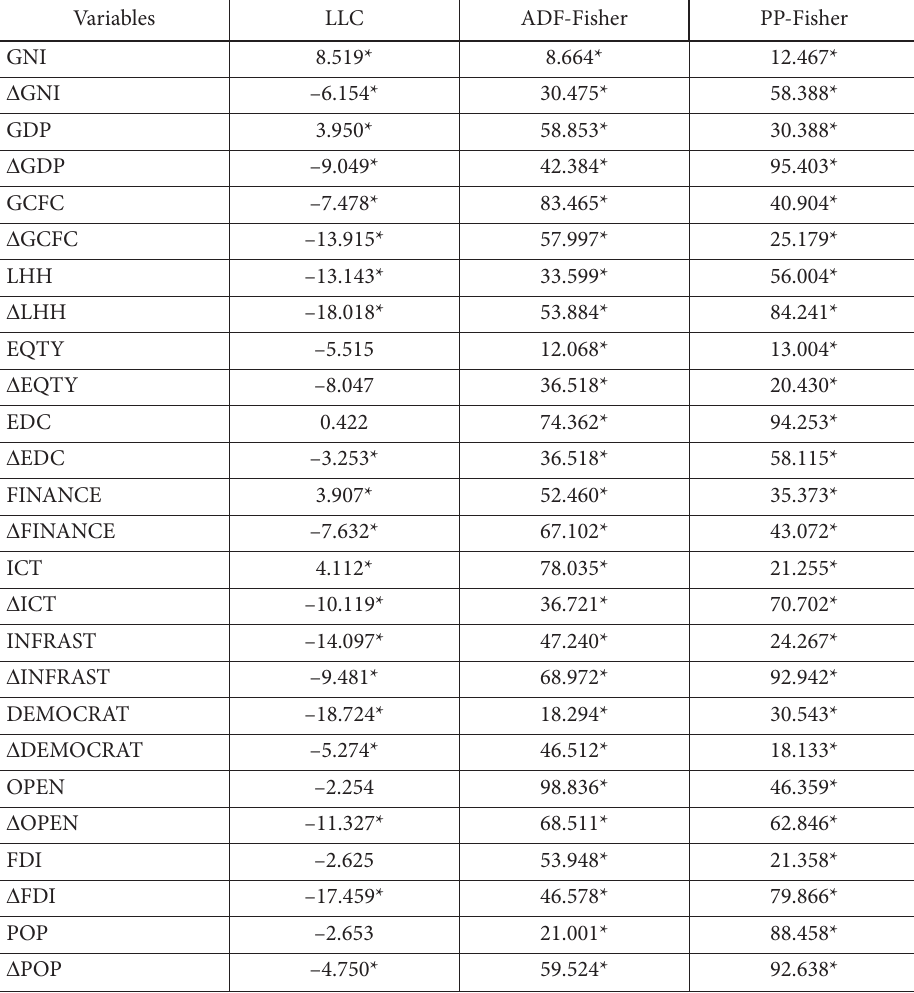
Table 3. Result of Unit root test (source: author’s computation using E-views 9.0)